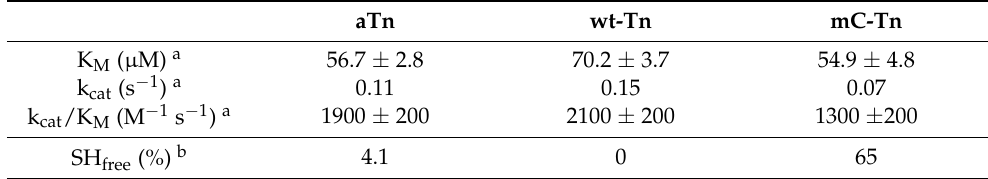
Table 1. Overview of the catalytic parameters for Bz-Arg-AMC turnover and proportion of free thiol (SH free ) species for Tn variants. aTn